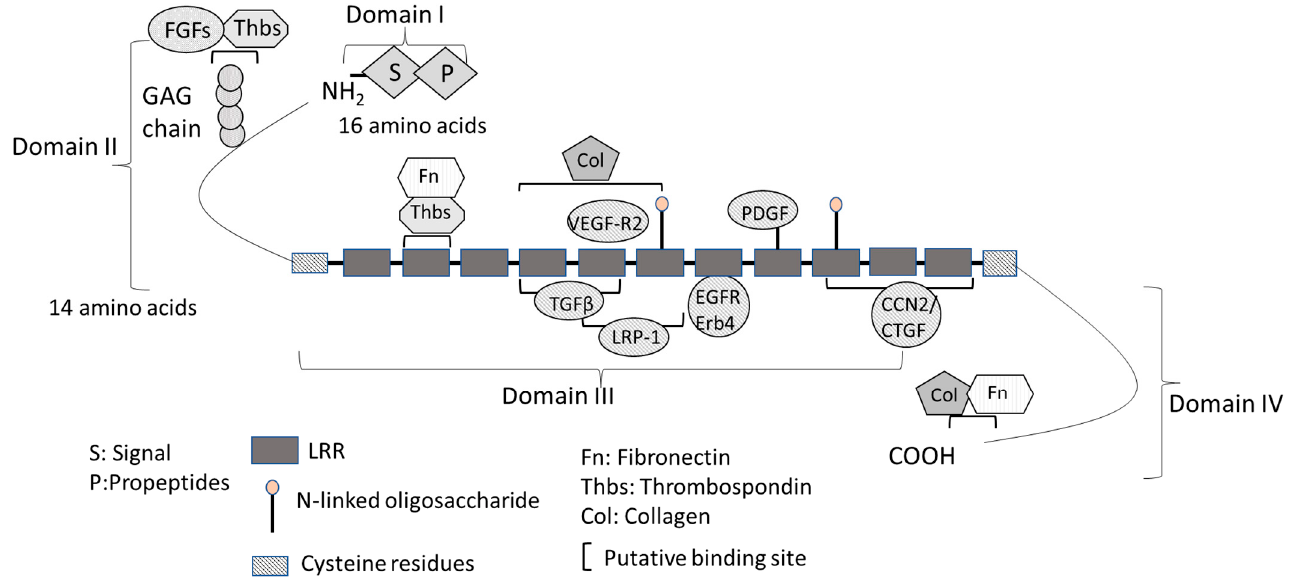
Figure 1. Structural and putative functional features of the decorin (DCN) molecule. Mammalian decorin contains core proteins and a glycosaminoglycan (GAG) side chain attached to a serine residue near the N terminus. Four domains of core proteins (I–IV) of DCN are shown. In domain I, the initial 16-amino-acid long signal peptide directs the incipient core protein to the rough endoplasmic reticulum and is cleaved via the co-translational pathway. In domain II, the propeptide is composed of 14 amino acids and regulates the attachment of the GAG chain. The protein core consists of tandem leucine-rich repeats (LRRs) flanking cysteine-rich disulfide domains. Twelve LRRs in domain III comprise the major central domain. Most decorin ligands share an interface with decorin at its core protein, an important hub for the extracellular matrix, cell surface receptors, and growth factors. Decorin has a high-affinity binding site for collagen (Col) at LRRs 4–6 and a low-affinity site at the C-terminus. The binding sites of TGF- β isoforms are LRR4 and LRR5 at the decorin core protein in domain II. The LRR7 domain binds to EGFR and ErB4 and activates the MAPK pathway. Decorin interacts with multiple growth factor signaling pathways. The carboxyl terminus domain and binding sites for fibronectin Fn and collagen Col can be found in domain